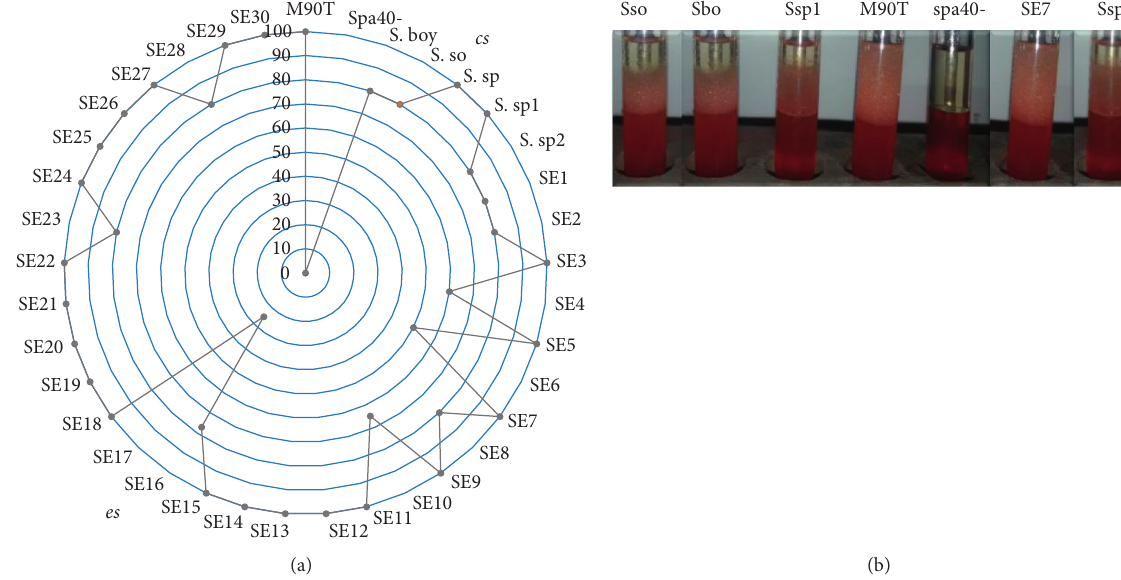
Figure 6: Emulsification index after Congo red induction. (a) cs: clinical strains; es: environmental strains; Pae: P. aeruginosa used as positive control; M90T: Shigella flexneri 5a strain M90T; spa40 -: S. flexneri spa40 mutant; Sbo: S. boydii ; Sso: S. sonnei ; Ssp, Ssp1, Ssp2: Shigella sp. from clinical strains; SE1 to SE30: Shigella sp. from environmental strains. (b) Emulsification index appearance of some Shigella strains.